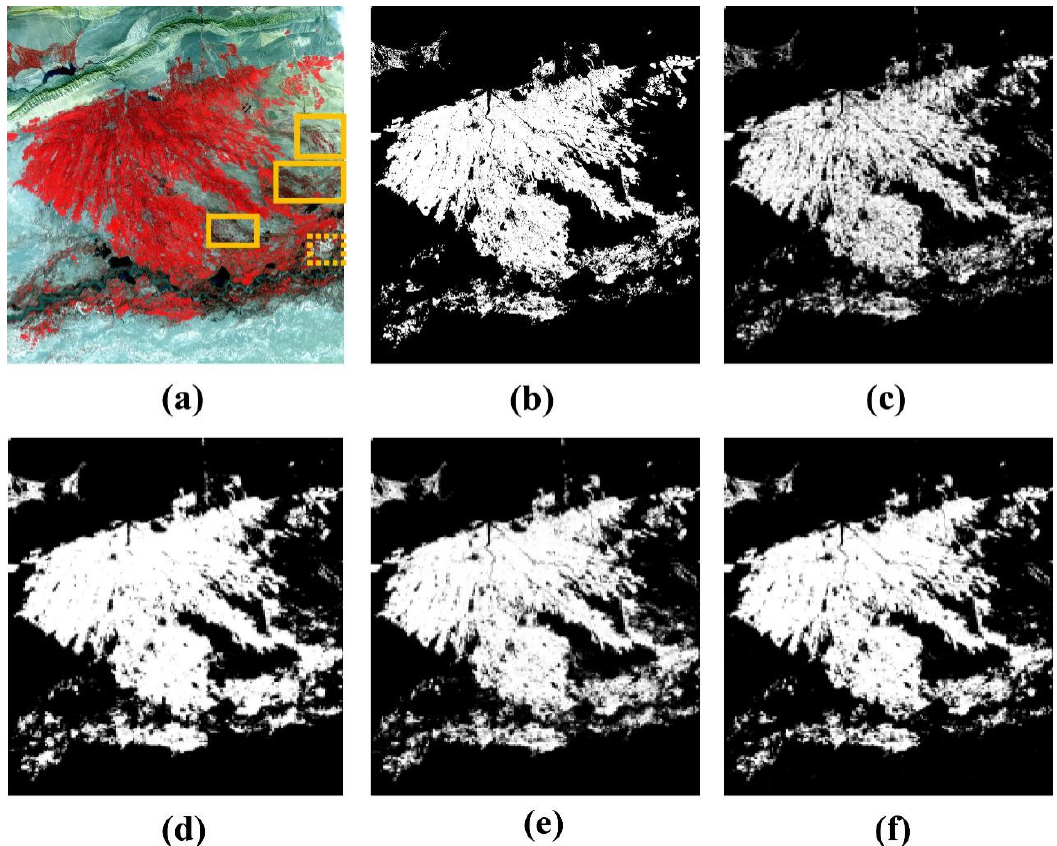
Figure 5. Comparison of the cotton identification effect of different models in Wei-Ku oasis on 21 September 2018. ( a ) False color composite remote sensing images, and cotton identification result by ( b ) the DenseNet, ( c ) the ResNet, ( d ) the VGG, ( e ) the SegNet, and ( f ) the DeepLab v3+. The white color indicates the identified cotton, the yellow solid line depicts mountain area, and the yellow dashed line depicts cloud area.